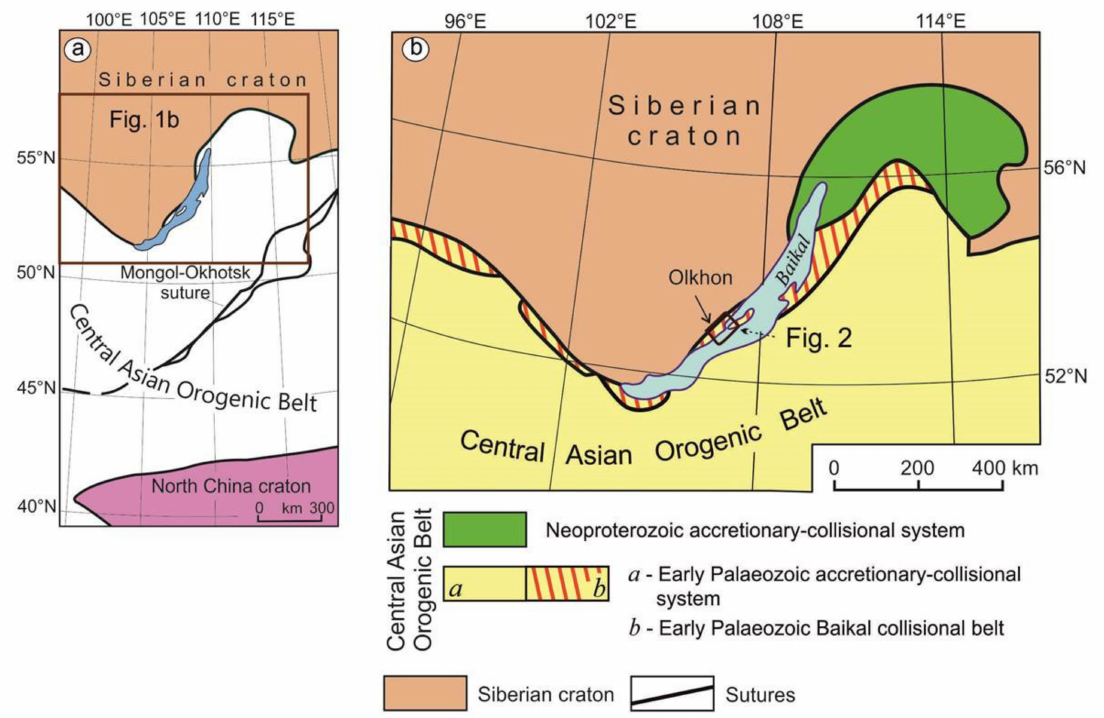
Figure 1. Simplified tectonics of Central Asia ( a ) and terranes in the Early Paleozoic Baikal collisional belt of northern Central Asian Orogenic Belt (CAOB) ( b ), modified after